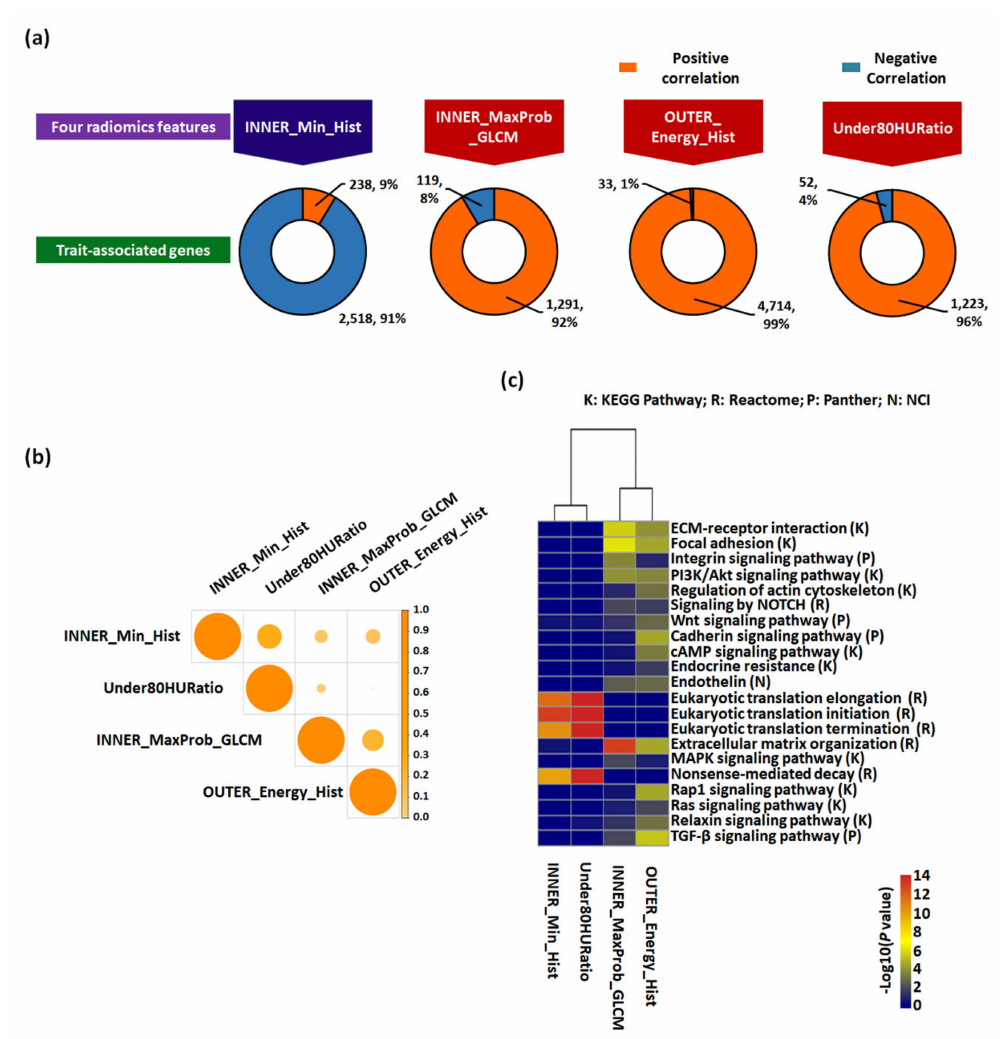
Figure 3. Trait-associated genes and their functional enrichment analysis. ( a ) Each gene set correlated with four radiomic features in the genomic discovery cohort ( n = 11). Genes that were significantly associated with four radiomic features were identified by Spearman’s correlation analysis, of which significantly correlated genes ( p < 0.05) were selected. Positive and negative Spearman’s rank correlation coe ffi cients were distinguished by di ff erent colors. ( b ) Heatmap of the similarity between eachtrait-associatedgenecalculatedbytheJaccardsimilarityindex(coe ffi cient). ( c )Heatmapofpathway enrichment of trait-associated genes. Multiple pathway analyses, including Kyoto Encyclopedia of Genes and Genomes (KEGG) Pathway, Reactome, Panther, and National Cancer Institute-Pathway Interaction Database (NCI-PID), were